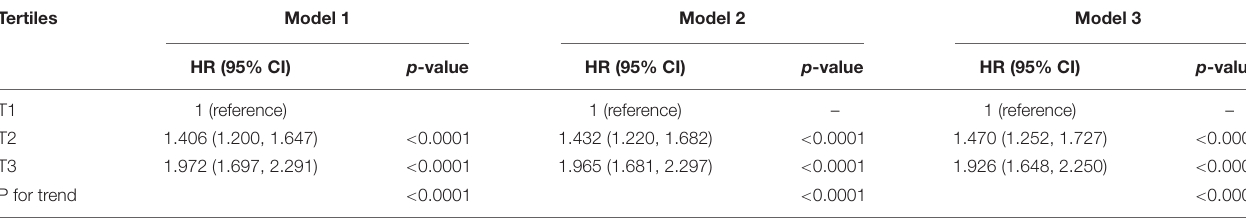
TABLE 2 | Associations of UA with incident of ischemic stroke recurrence.